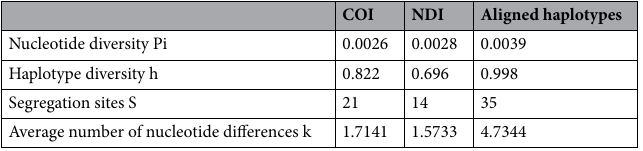
Table 1. Genetic diversity parameters of the two separated and combined mitochondrial DNA markers of E. aethiops.